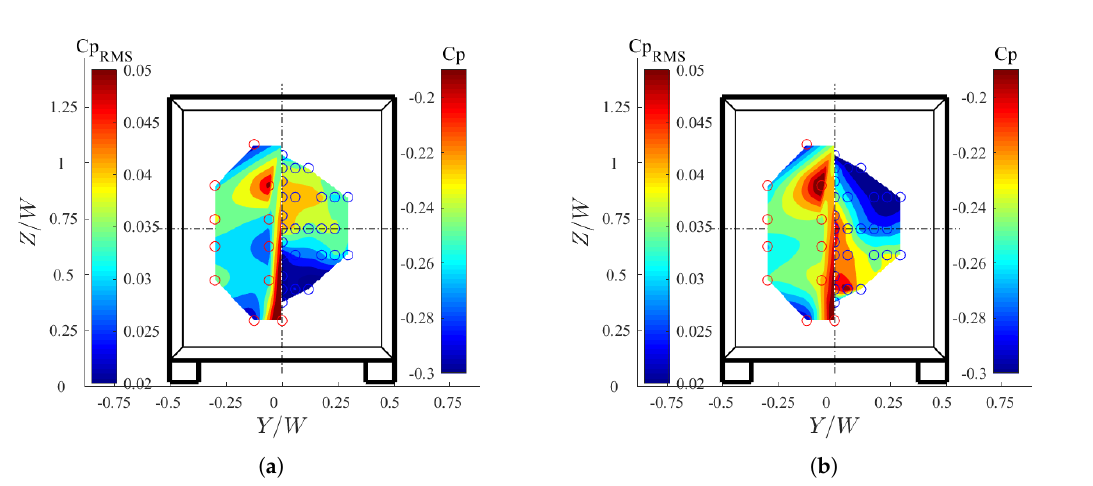
Figure 6. Distributions of static pressure coefficient ( c p , right) and RMS of the pressure coefficient ( c p , left) on the rear face: ( a ) lower jet forcing, V j / V ∞ = 1.4; and ( b ) lateral jets forcing, V j / V ∞ = 1.5. RMS The location of the actual measurement points is schematically represented using blue and red circles for the static pressure and fluctuating pressure, respectively. The contour representation is obtained by interpolating the measurements on a structured